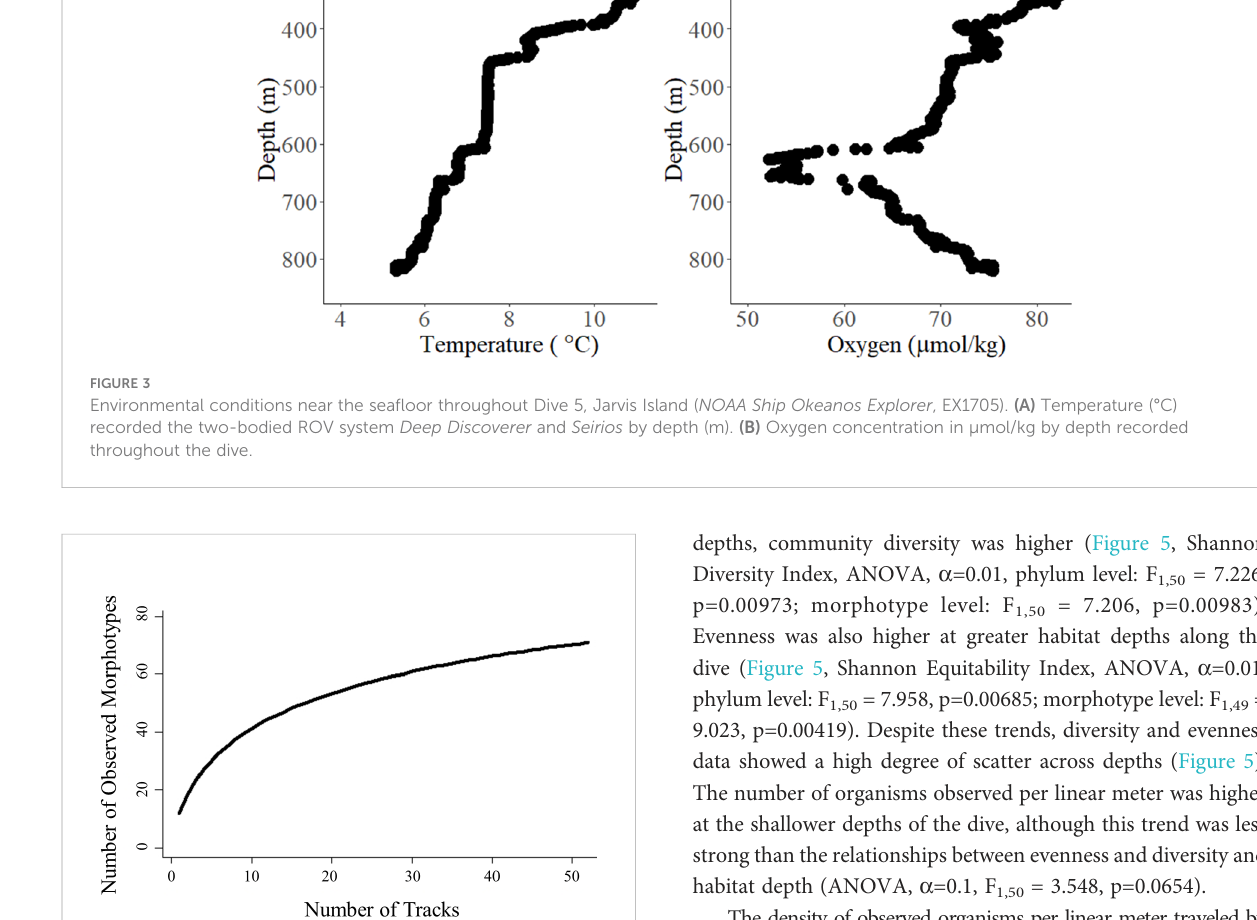
FIGURE 4 Species accumulation curve modeling the number of morphotypes likely to be observed with increasing sampling effort. Tracks represent dive sections of distinct rugosities. Morphotypes are classi fi ed by common name (e.g., shrimp, octopus, gold coral). The model predicts 112.07 types of organisms present in this community